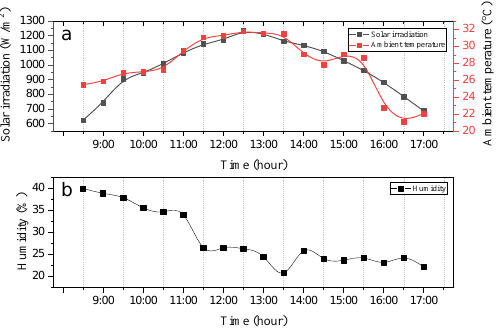
Figure 6. ( a ) Solar irradiation and ambient temperature and ( b ) humidity.